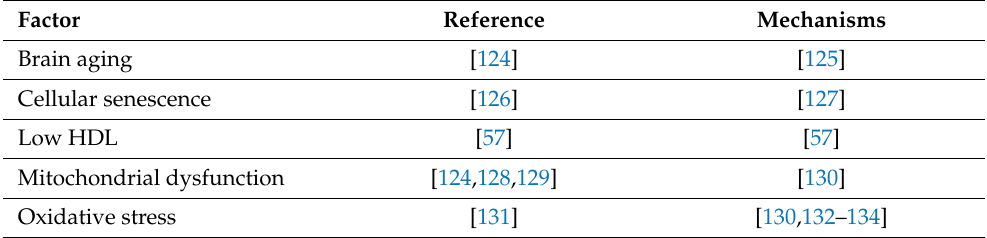
Table 10. Mechanisms by which vitamin D deficiency increases the risk of AD.